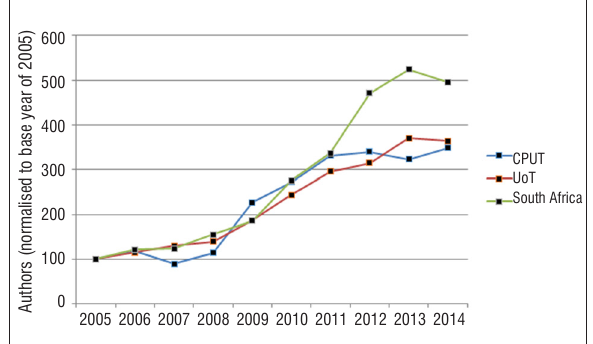
Figure 3: Growth in the number of authors over a 10-year period.